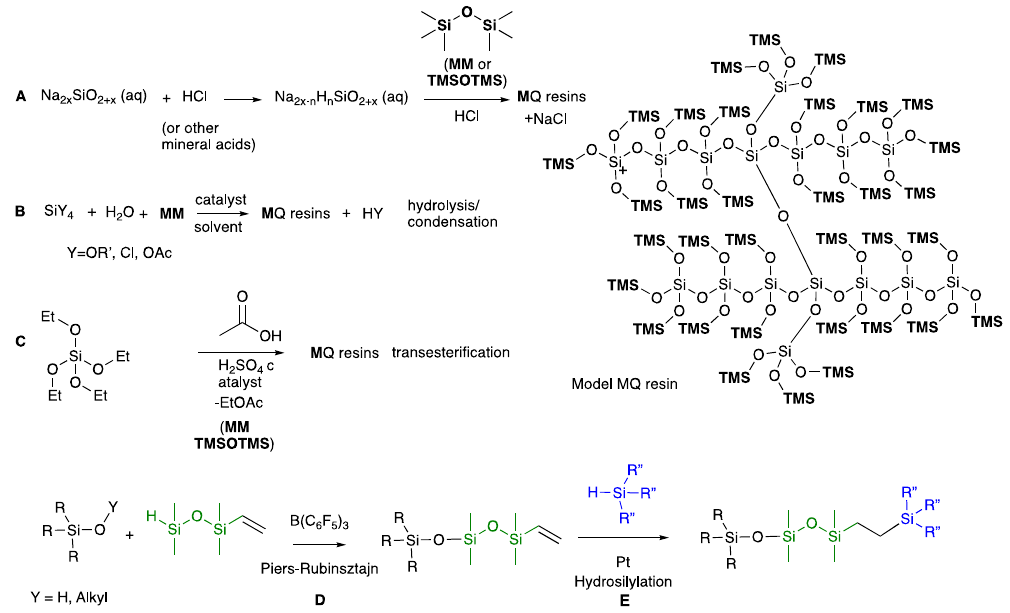
Figure 1. Simple preps of MQ resins by ( A ) acidification of sodium silicate following by capping; ( B ) co-hydrolysis; ( C ) transesterification. ( D ) example of the Piers-Rubinsztajn reaction; ( E ) example of Pt-catalyzed hydrosilylation.